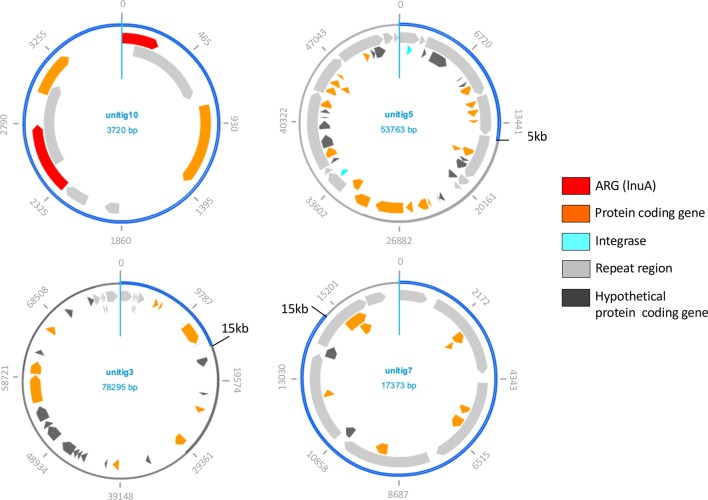
Plasmids reconstructed from long-read sequencing of a cultured dust isolate related to S. equorum.We targeted staphylococcoidal culture isolates from a dust sample (AF82) with metagenomically abundant Staphylococcus to characterize chromosomal and plasmidic ARGs. We identified and sequenced one such strain that proved to be Staphylococcus equorum (100% full-length rRNA gene identity). We further isolated its plasmid DNA for Nanopore sequencing (Methods), resulting in 4 complete or partial plasmids assembled using CANU / Pilon [53, 54].